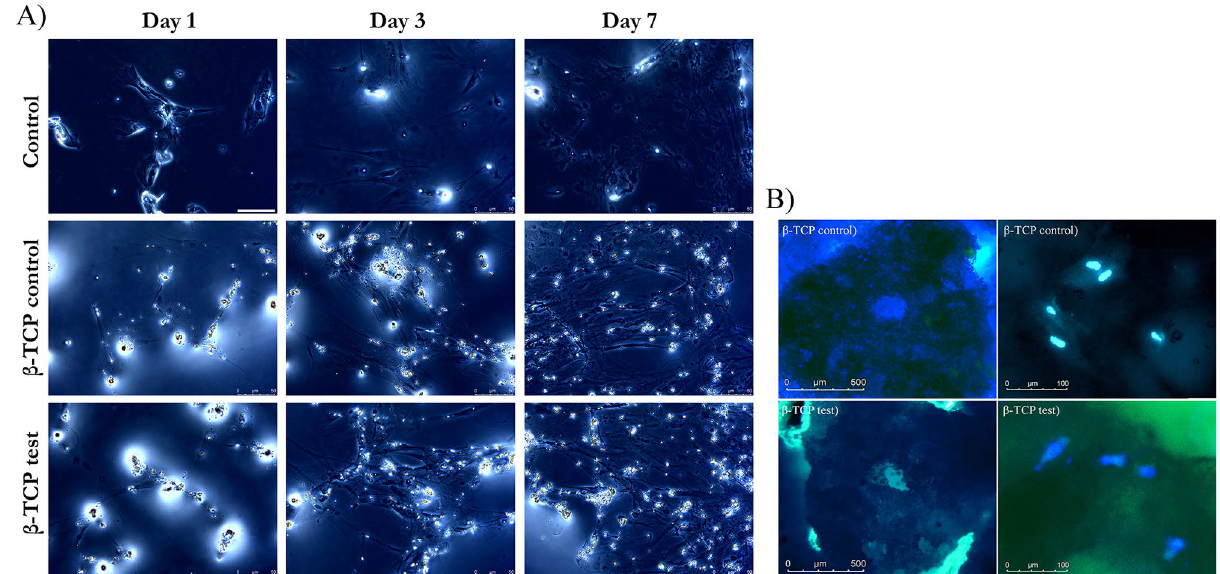
Figure 7. ( A ) Changes in hMSCs morphology at 1, 3, and 7 days. Day 1: Scarce spindle-shaped cells growing in the different media. Day 3: Cells with a more extended morphology had proliferated. Day 7: Cells showing a stage of development with filopodial extensions had proliferated. Magnification 40×. ( B ) 3D Fluorescent imaging with DAPI- phalloidin after 24 h at 20× and